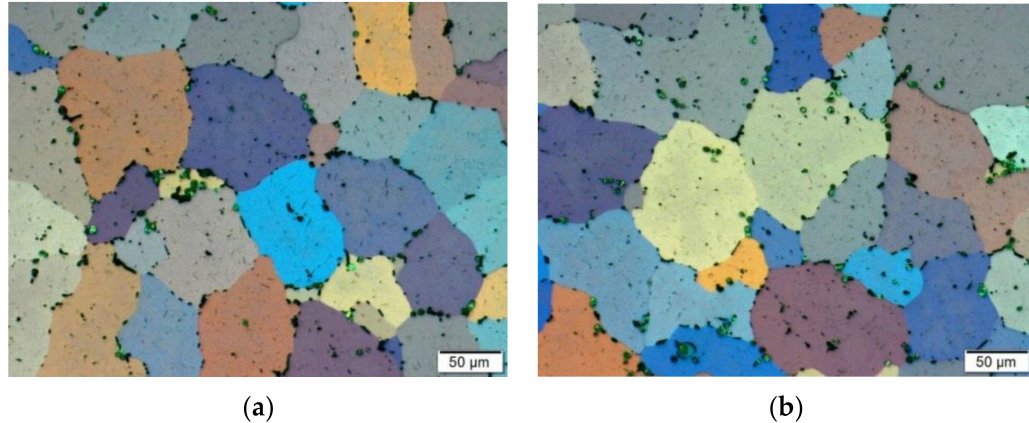
Figure 17. Microstructure of the 5019 aluminium alloy in the initial state, after the homogenisation process (before the deformation process): ( a ) sample centre; ( b ) sample edge; cross-section, magnification 200 × .